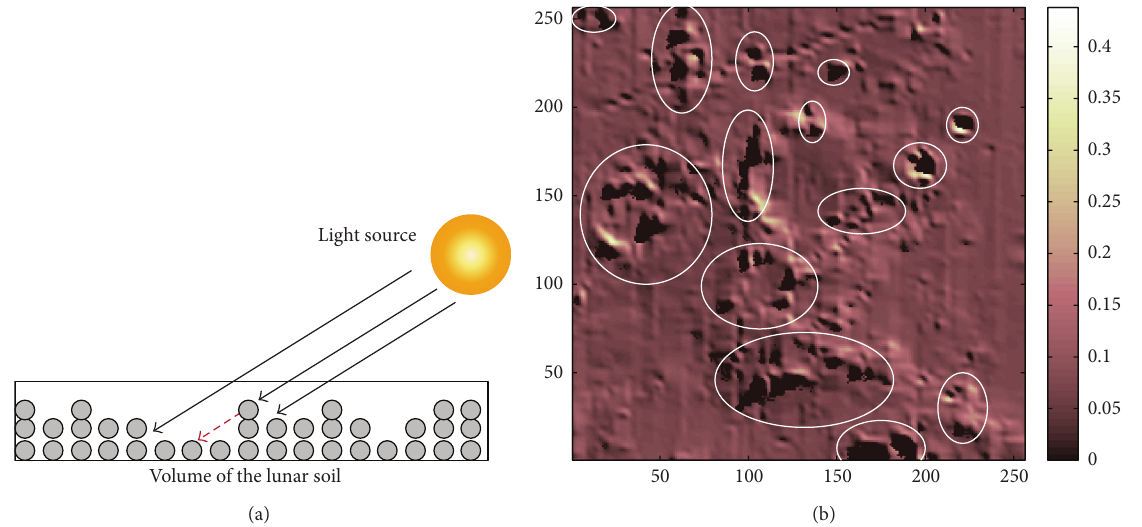
Figure 17: Simulation result with shadows caused by the blocked ray (size: 256 × 256